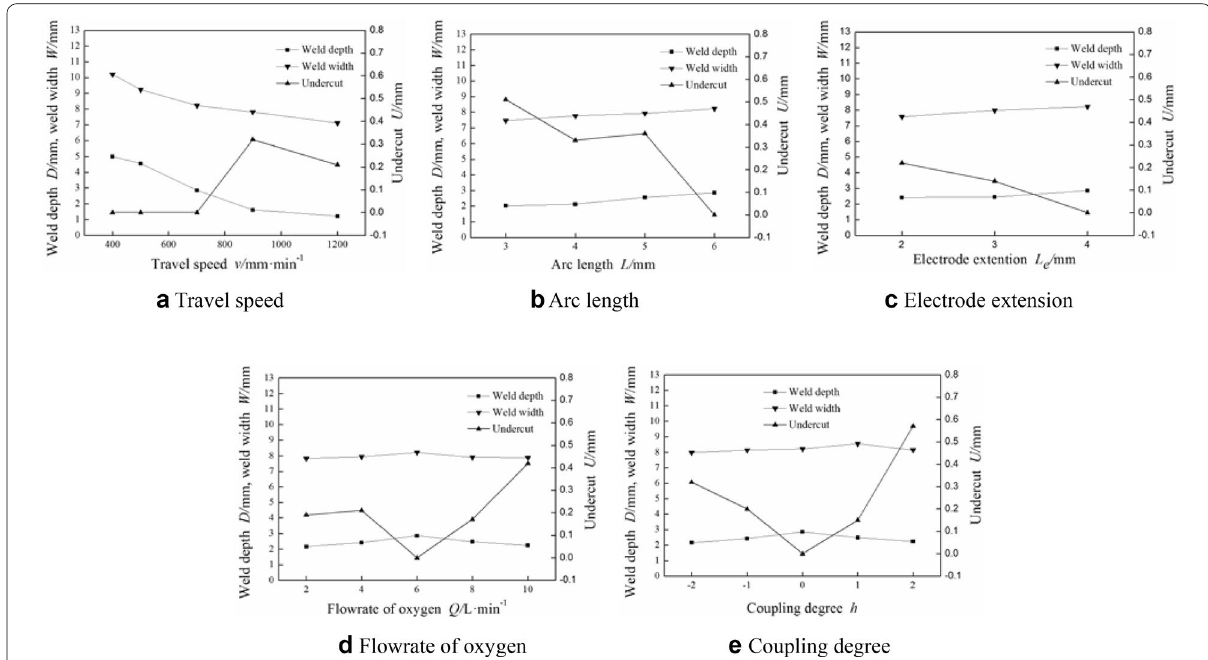
Figure 11 Effects of welding parameters on the GPCA‑TIG weld shape